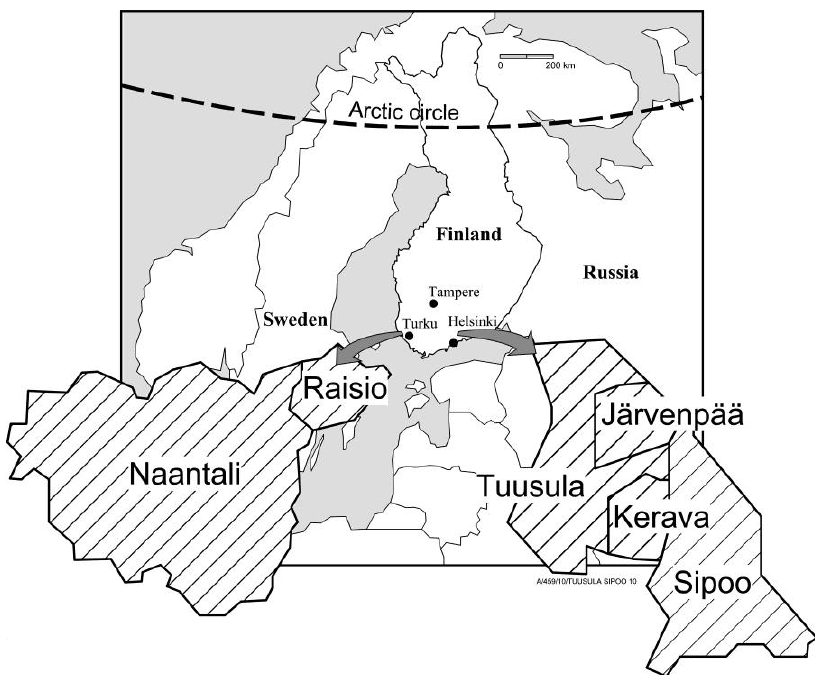
Figure 1. Location of the joint municipal authorities for water supply: Raisio-Naantali on the south-western coast close to Turku, and Tuusula region north of